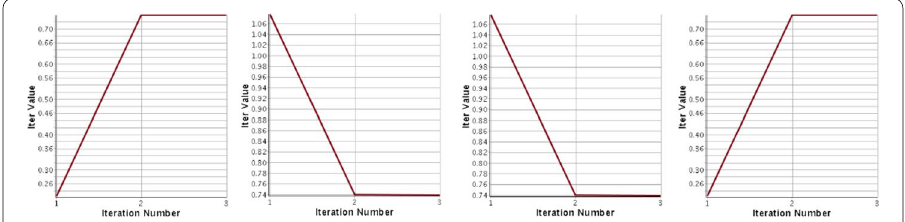
Fig. 1 Iteration values at different iteration numbers for 8th BM at different θ ( θ = − 1, − 0.5,0.5,1 ) respectively for g 1 ( x ) .